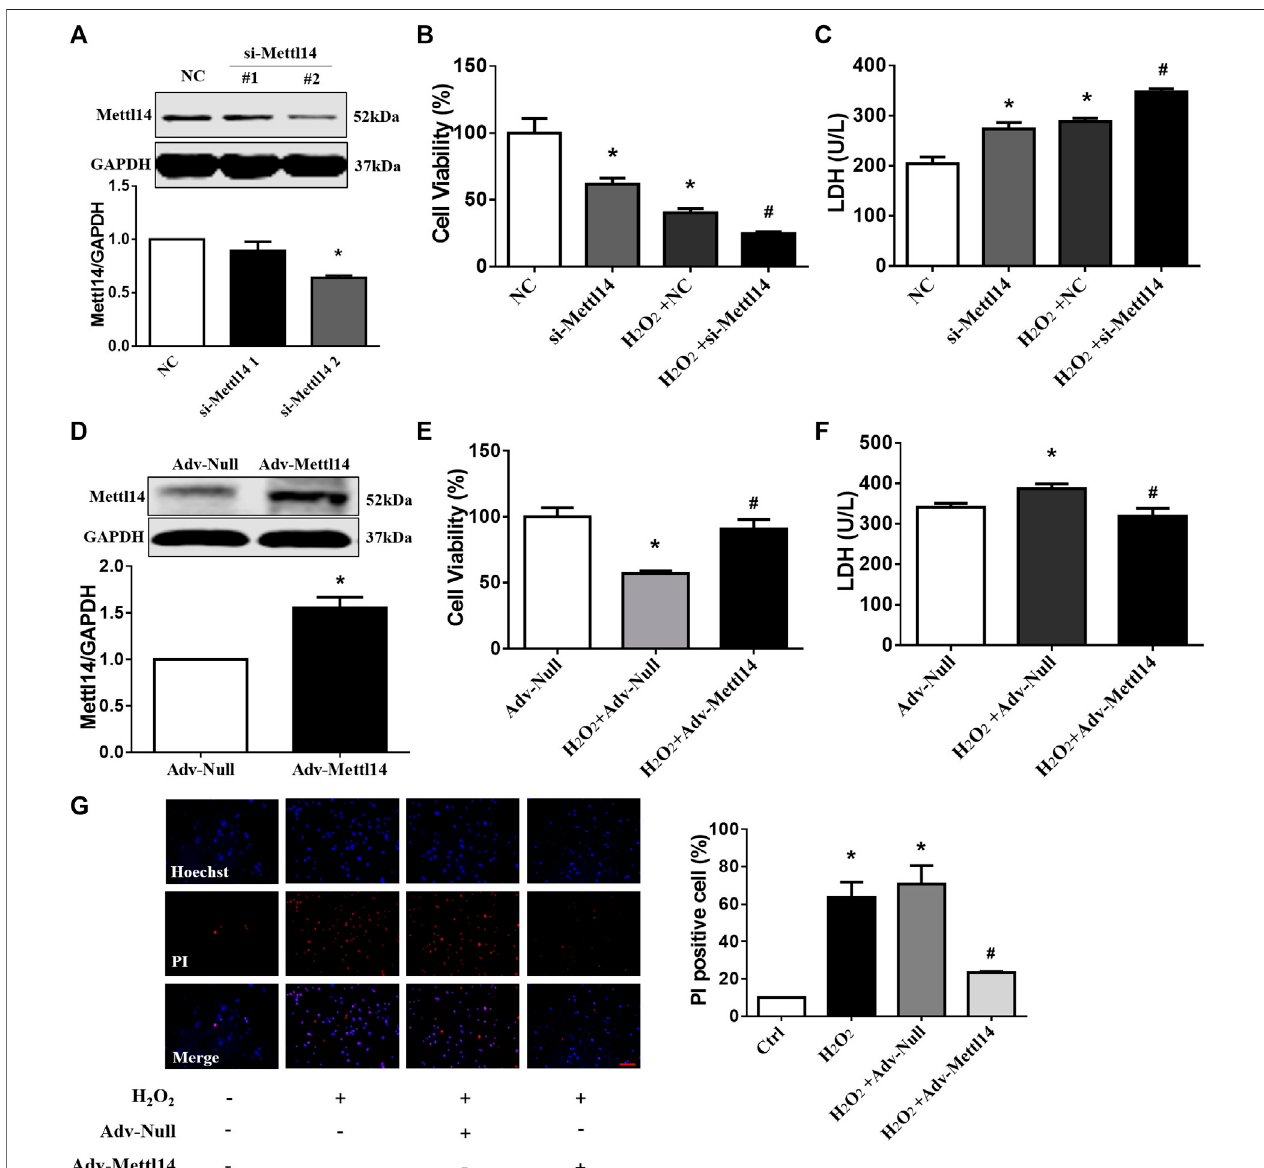
FIGURE 4 | Mettl14 reduces cardiomyocyte injury upon H 2 O 2 in vitro . (A) Cardiomyocytes were transfected with si-RNA and were treated with 100 µM H 2 O 2 for 12 h. The Mettl14 protein level in cardiomyocytes was analyzed by Western blotting. n (cid:2) 3 from three independent cultures. * p < 0.05 versus NC. (B) Cell viability was detectedwithCCK8.NC n (cid:2) 5,si-Mettl14 n (cid:2) 5,H 2 O 2 +NC n (cid:2) 6,H 2 O 2 +si-Mettl14 n (cid:2) 6.* p < 0.05versusNC. # p < 0.05versusH 2 O 2 +NC. (C) Culturemediumactivityof LDH was analyzed by using a lactate dehydrogenase assay kit. n (cid:2) 3 from three independent cultures. * p < 0.05 versus NC. # p < 0.05 versus H 2 O 2 +NC. (D – F) Cardiomyocytes were infected with Mettl14 expression vector or empty vector and were treated with 100 µM H 2 O 2 for 12 h. (D) The Mettl14 protein level in cardiomyocytes overexpressed Mettl14. n (cid:2) 4 from three independent cultures. * p < 0.05 versus Adv-Null. (E) Cell viability was detected with CCK8. n (cid:2) 6 from three independent cultures. * p < 0.05 versus Adv-Null. # p < 0.05 versus H 2 O 2 +Adv-Null. (F) Culture medium activity of LDH was analyzed by using a lactate dehydrogenase assay kit. Adv-Null n (cid:2) 3, H 2 O 2 +Adv-Null n (cid:2) 5, H 2 O 2 +Adv-Mettl14 n (cid:2) 5. * p < 0.05 versus Adv-Null. # p < 0.05 versus H 2 O 2 +Adv-Null. (G) PI staining of damaged cardiomyocytes (red); DAPI stains all nucleus (blue), scale bar (cid:2) 100 µm n (cid:2) 3 from three independent cultures. * p < 0.05 versus Ctrl. # p < 0.05 versus H 2 O 2 +Adv-Null. Data are represented as mean ± SEM.